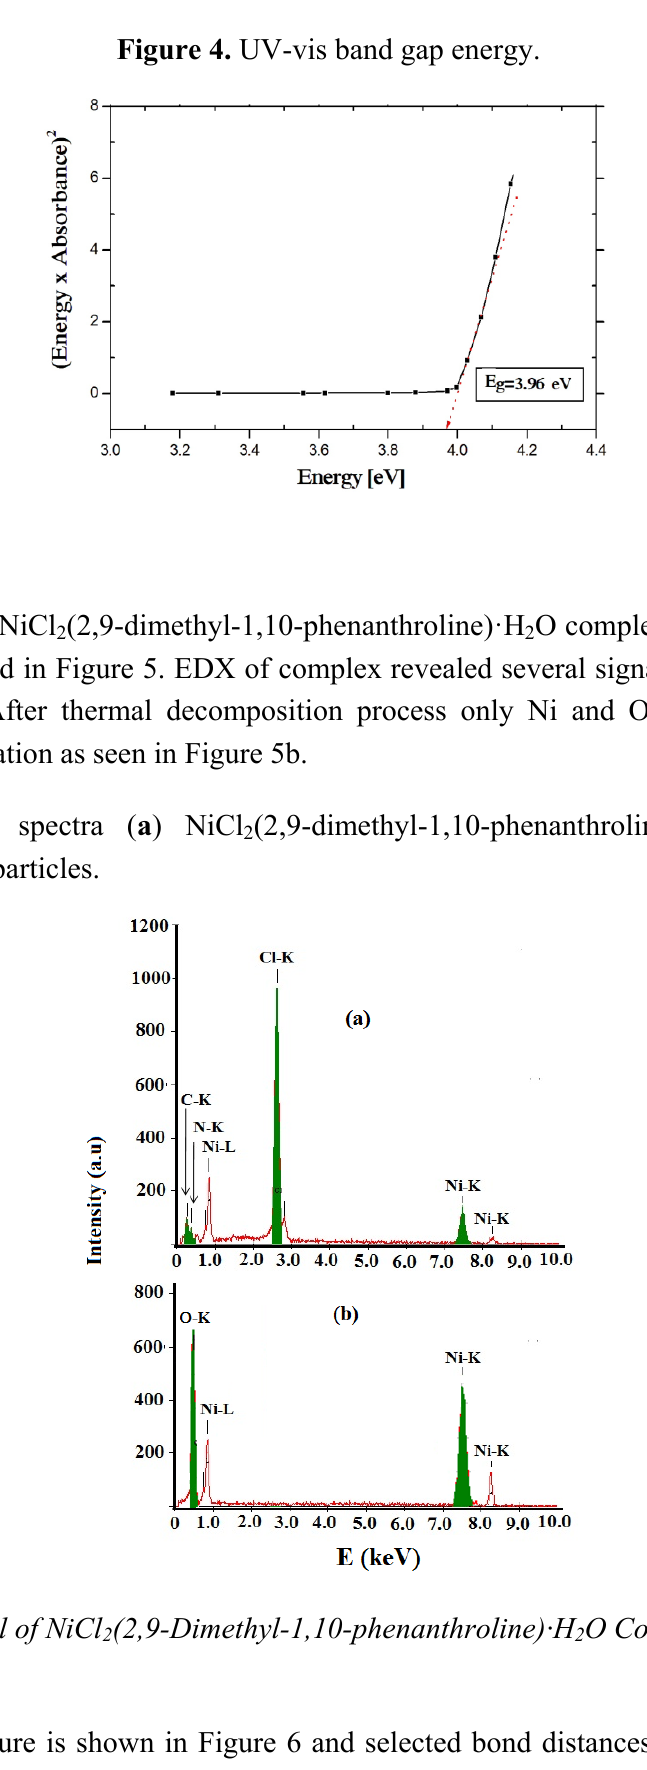
Figure 4. UV-vis band gap energy.